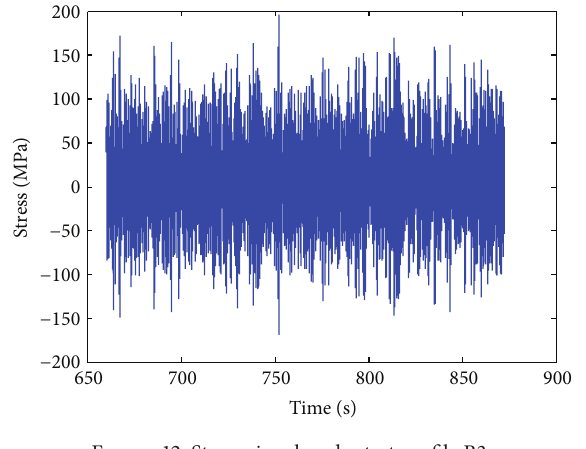
Figure 12: Stress signal under test profile B3.